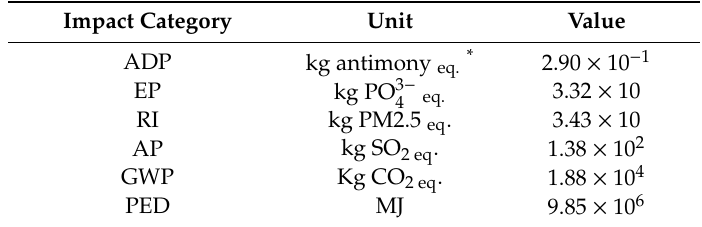
Table 2. Impact assessment results (characterization step) of plywood manufacturing for 1 m 3 of finished plywood.